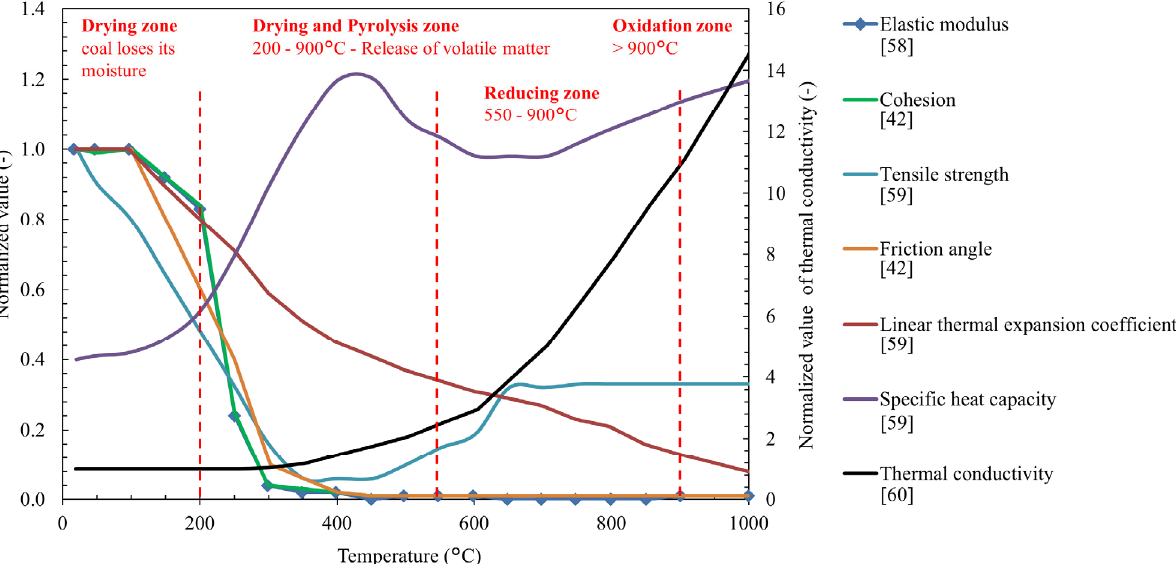
Figure 2. Trend of normalized thermo-mechanical properties of sandstones as a function of temperature.